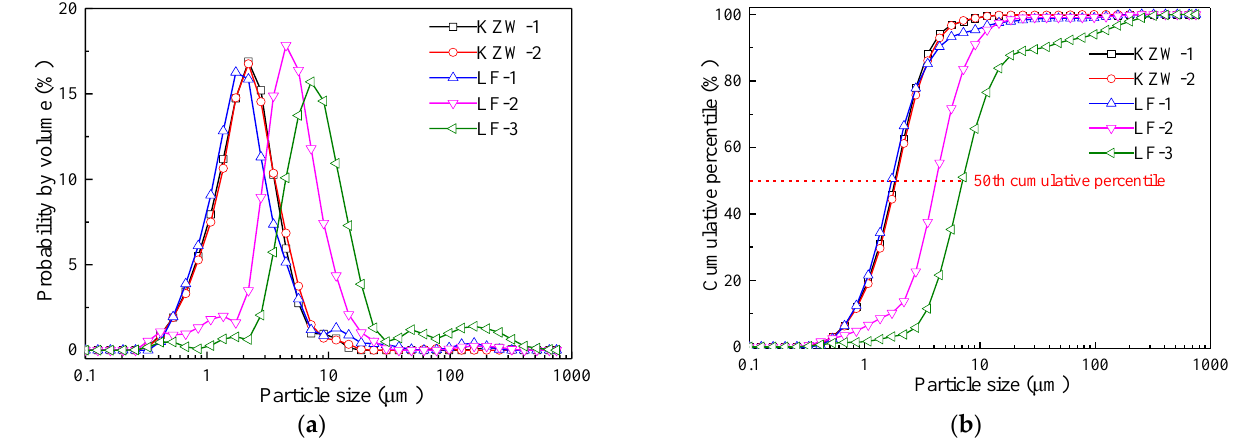
Figure 1. The particle size distribution of bitumen emulsions, ( a ) Differ ential distribution, ( b ) Cumulative percentile.